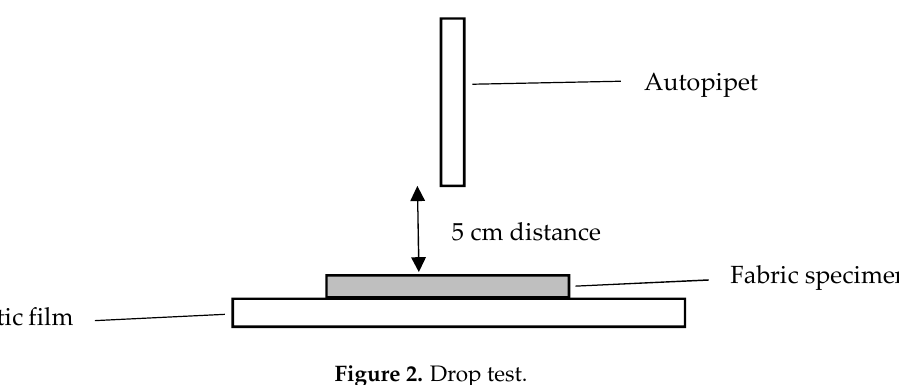
Figure 2. Drop Figure 2. Drop test.